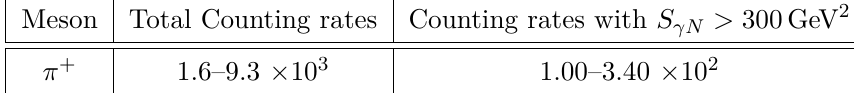
Table 4 . Estimated counting rates at p-Pb UPCs at LHC for π + γ